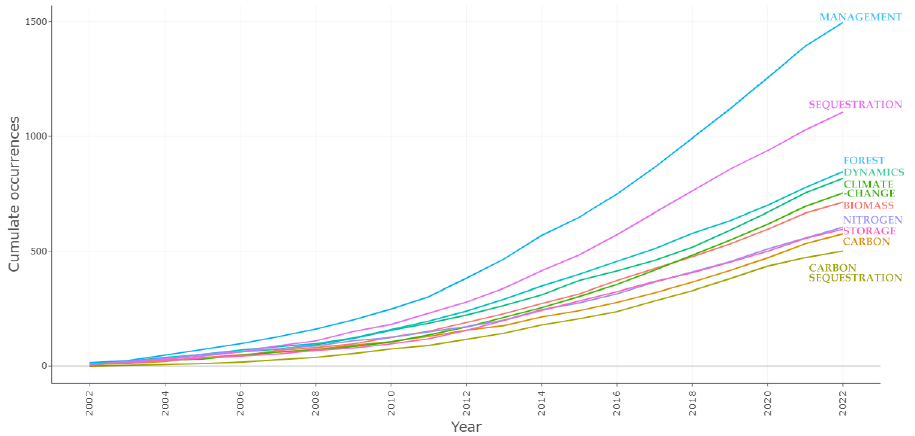
Figure 7. The thematic evolution